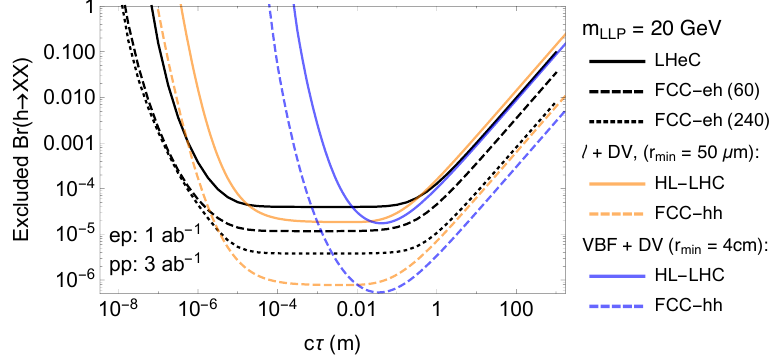
Figure 11 . Projected exclusion limits on exotic Higgs decay branching fraction to LLPs X as a function of lifetime c(cid:28) for the LHeC, FCC-eh (60) and FCC-eh (240) with 1 ab (cid:0) 1 of data. The excluded branching ratio scales linearly with luminosity under the assumption of no background. The LLP mass in the plot is 20 GeV, but for di(cid:11)erent masses the curves shift in c(cid:28) roughly by a factor of m LLP = (20 GeV). The search at the ep collider requires only the trigger jet to locate the PV and a single DV from LLP decay. For comparison, assuming X decays hadronically, we show a somewhat realistic estimate for the sensitivity of pp colliders with 3 ab (cid:0) 1 and without background (blue), as well as a very optimistic estimate which assumes extremely short-lived LLP reconstruction (orange), from